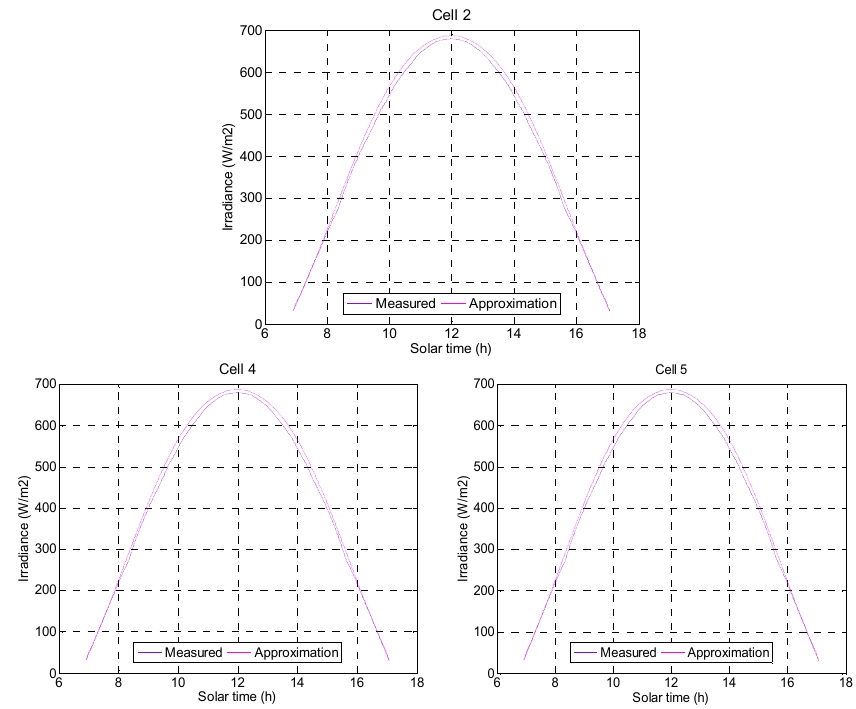
Figure 7. Comparison of radiation results for data from one day and continuous measurements using Equation (4) for three other different cells.